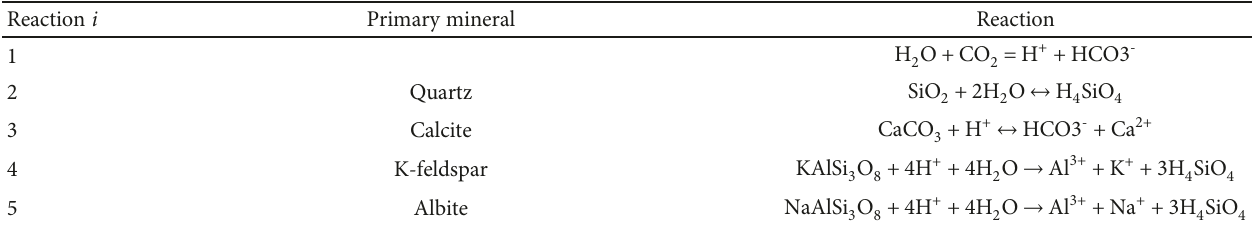
Table 1: Chemical reaction